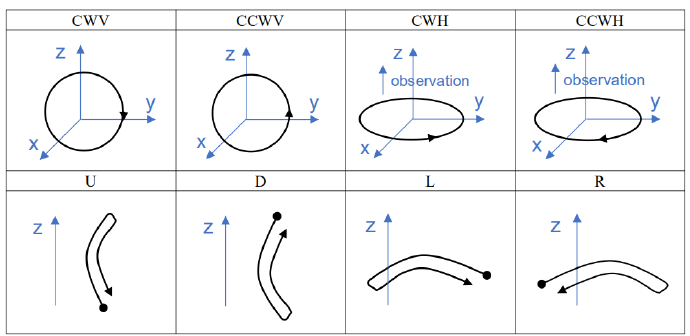
Figure 5. Schematic diagram of eight gestures in spatial coordinate form. Table 2. Eight gestures and their code templates.